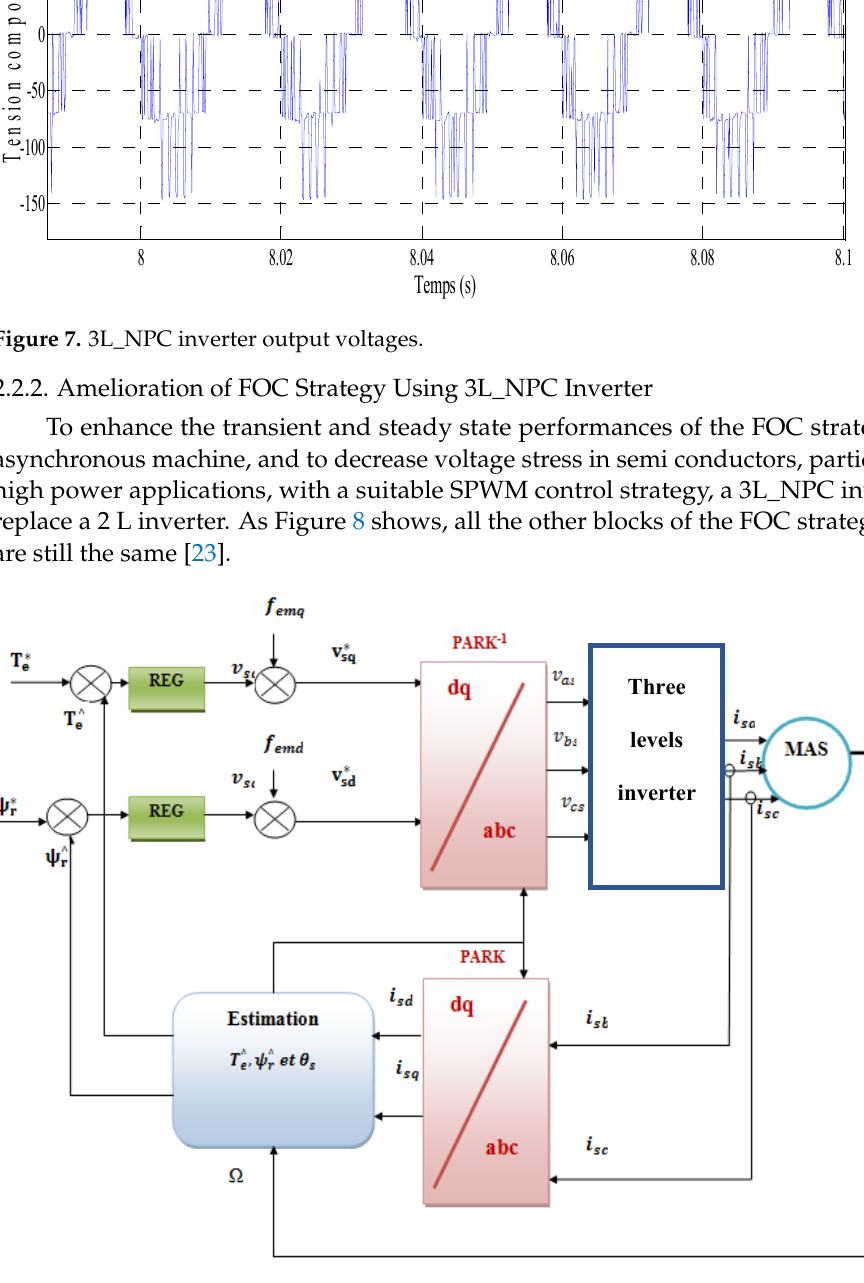
Figure 8. FOC of IM using 3L_NPC inverter. 2.2.3. Closed Loop Conditions The rotor speed closed loop DFOC system is shown in Figure 9. The PI and IP con- troller scheme are, respectively, given in Figures 10 and 11. To show an aperiodic representation of the previous presented system, we find fol- lowing Equations (9) and (10):